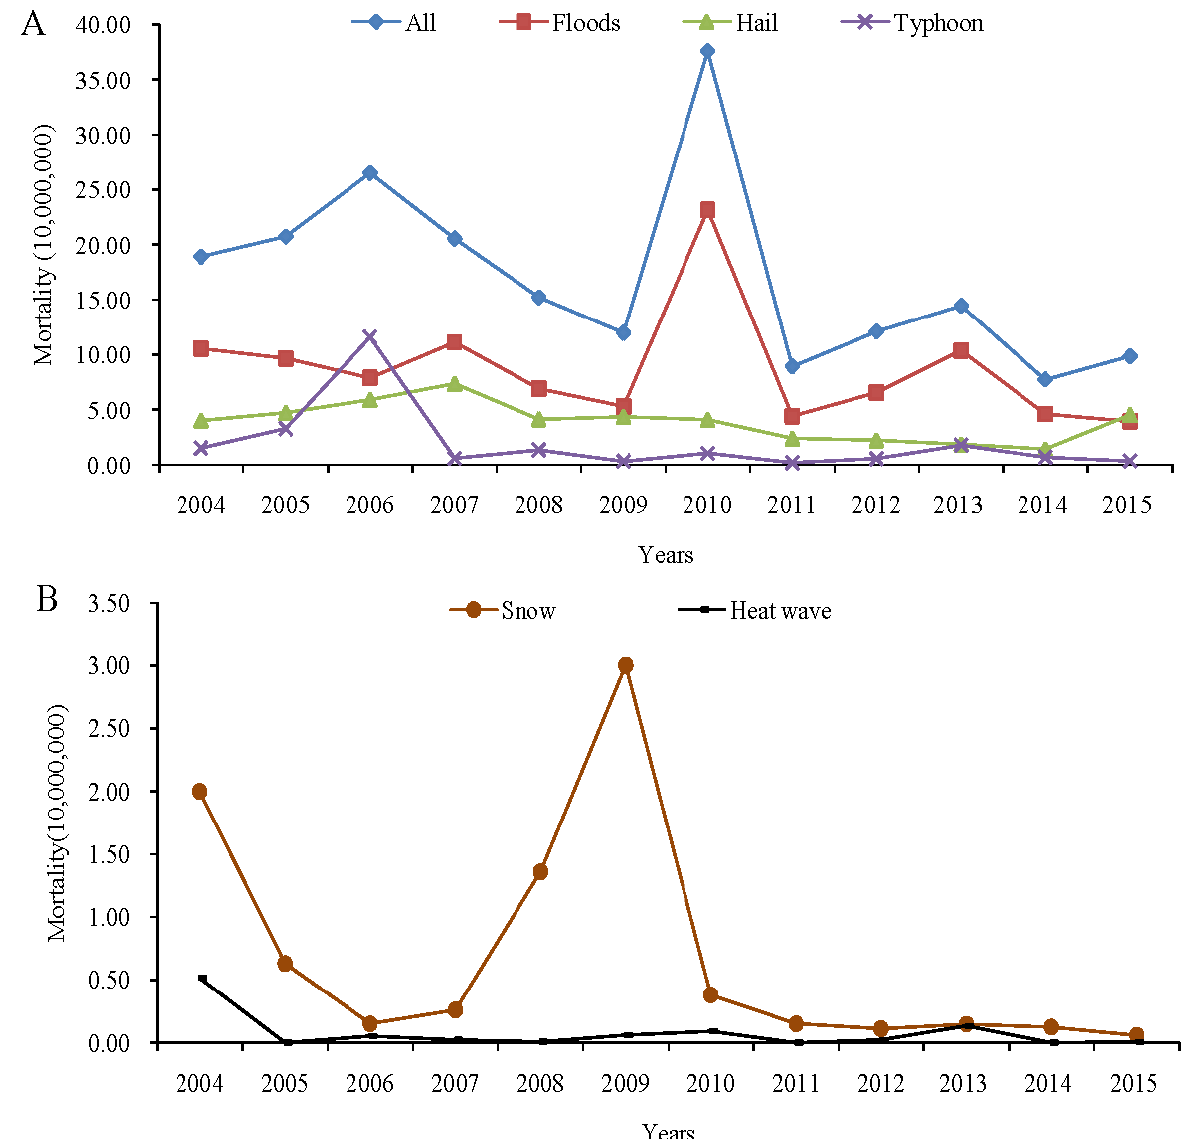
Figure 1. Trend chart for meteorological disasters related mortality, 2004–2015. ( A ). All, floods, hail and typhoon ( B ). Snow and heatwave.